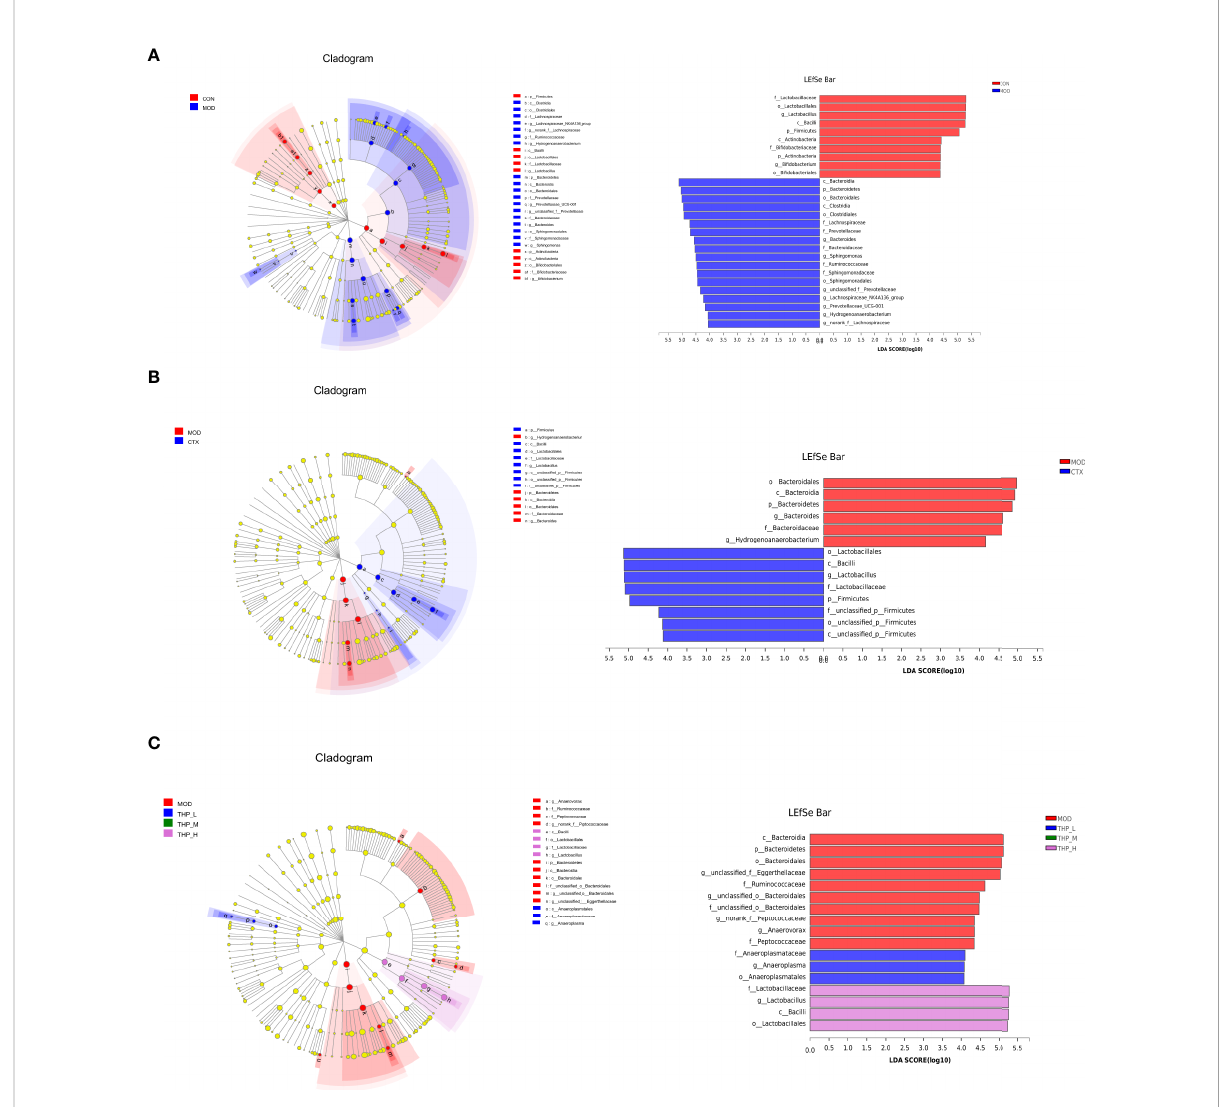
FIGURE 4 LEfSe comparison of intestinal microbiota. (A) CON group and MOD group. (B) CTX group and MOD groups. (C) MOD, THP-L, THP-M and THP-H